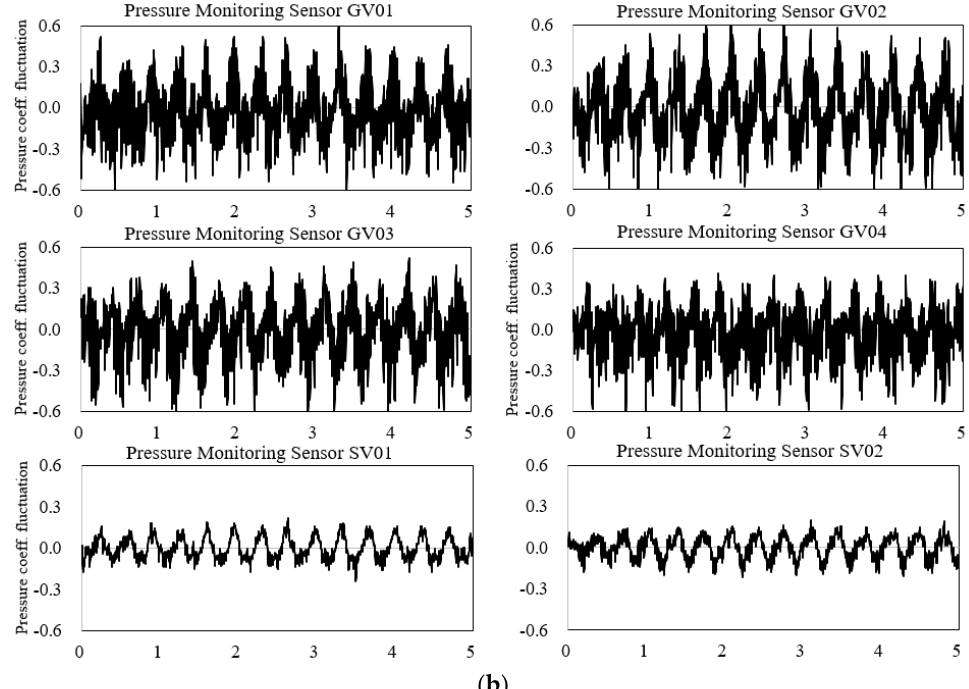
Figure 11. Time histories of pressure fluctuations at representative monitoring points in the vaneless space under the runaway condition: ( a ) Full-scale model ( n ed : 2.1171, Q ed : 0.0708 and T ed : 0.0052); ( b ) laboratory-scale model ( n ed : 1.9811, Q ed : 0.0644 and T ed : 0.0033).